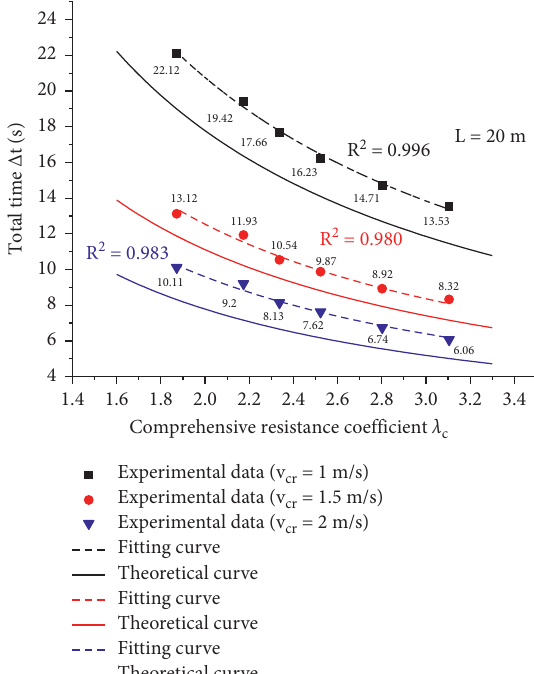
Figure 8: L � 20 m, the total time under different λ